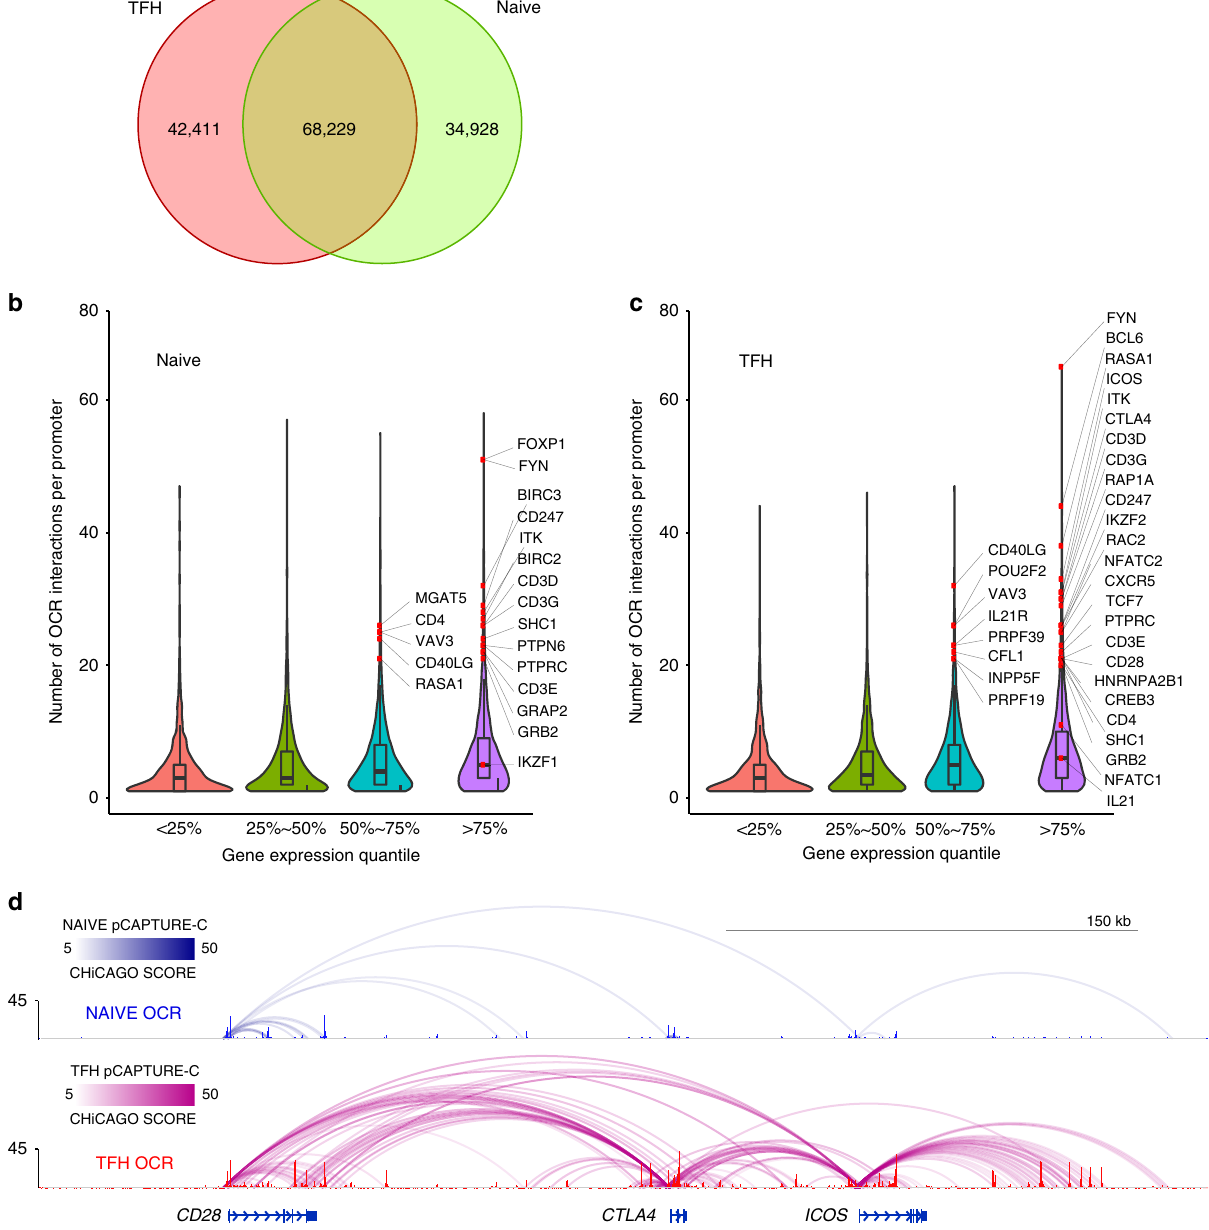
Fig. 5 Analysis of promoter-open chromatin connectomes in naive and follicular helper T cells. a Comparison of promoter-OCR interactions between TFH and naive T cells. Relationship between the number of promoter-OCR interactions at a gene and its corresponding expression level in naive T cells ( b ) and TFH ( c ) are depicted with genes with recognized functions in naive and TFH labeled. d Promoter-OCR interactions and ATAC-seq accessibility at the CD28, CTLA4, and ICOS loci in TFH (red) and naive T cells (blue). A CHiCAGO score lower threshold of 5 was